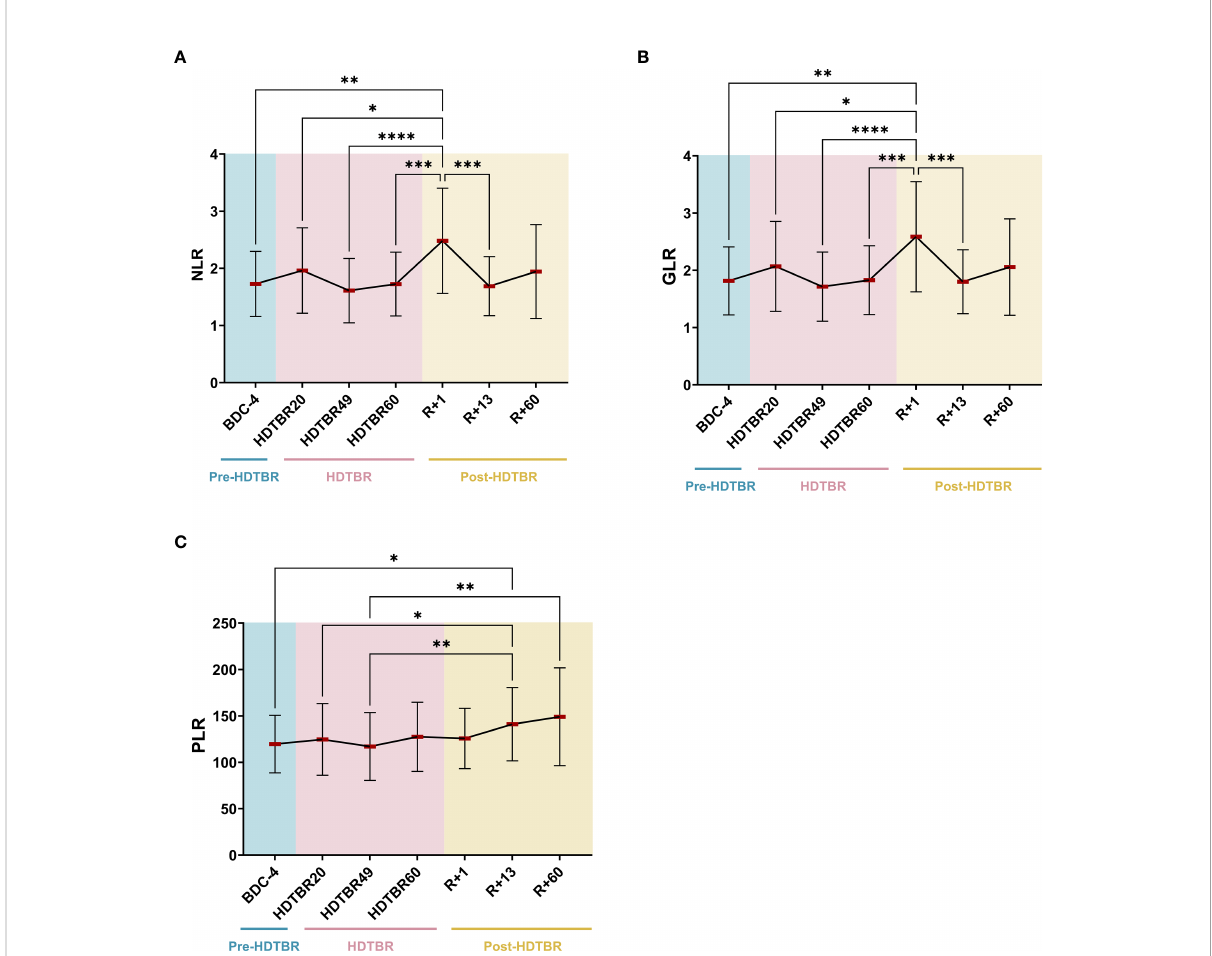
FIGURE 3 Evolution of NLR (A) , GLR (B) and PLR (C) ratios before, during and after two months of head-down tilt bed rest. As no statistically signi fi cant differences between the supplemented and non-supplemented groups were observed (Figure 2), individuals of both groups were pooled. n=20, except at R+60, where n=17. Horizontal bars indicate the mean. Statistically signi fi cant differences were revealed using either one-way ANOVA or a linear mixed effects model analysis. * p<0.05; ** p<0.01; *** p<0.001; **** p<0.0001. BDC, baseline data collection (blue); HDTBR, head- down tilt bed rest (pink); R, recovery